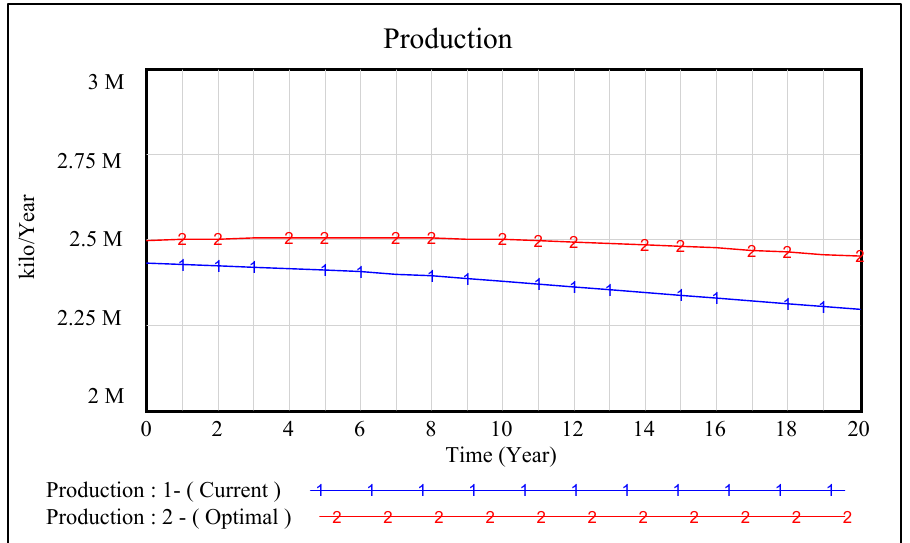
Figure 20. The comparison of the effect of the optimal amounts on milk production.